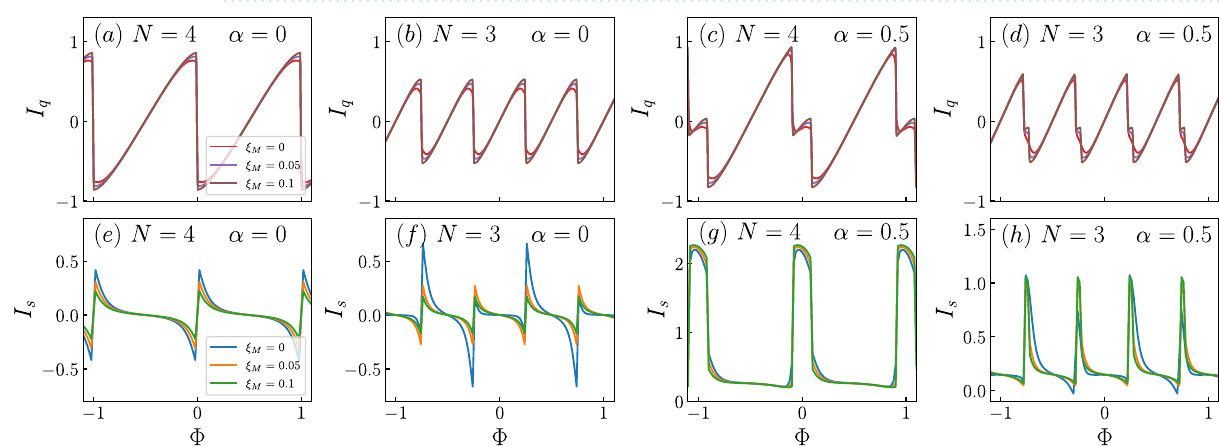
Figure 4. Quasiparticle spectra and corresponding charge and spin persistent currents, I q and I s respectively, for = (cid:31) = ξ M = 0 . The number of sites, N , and the Rashba spin-orbit coupling, α , are indicated in the figures. (cid:31) 1 2